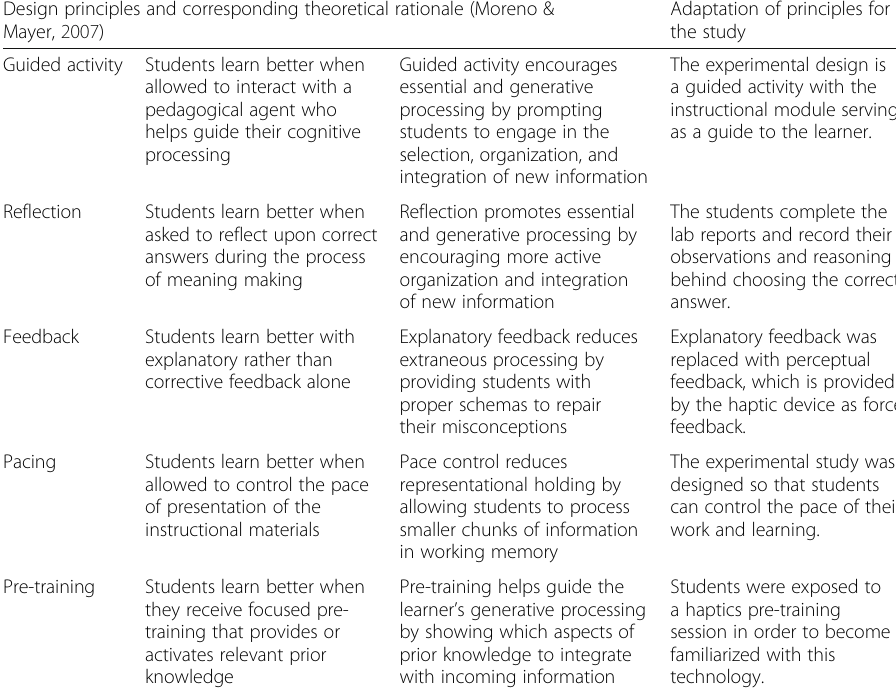
Adaptation of principles for the study